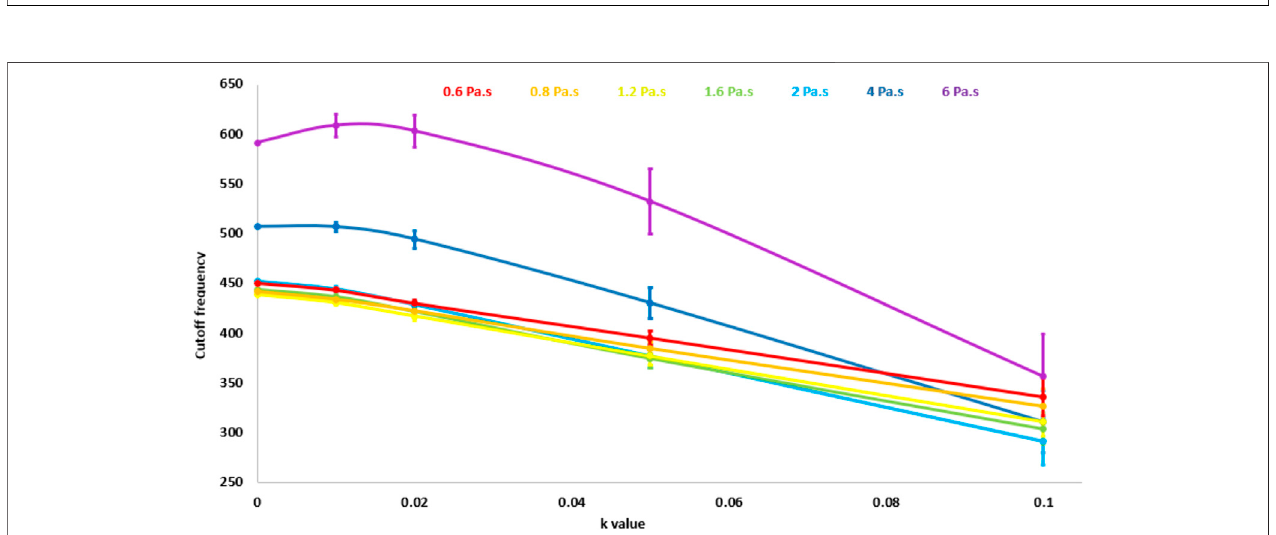
FIGURE5| Cutofffrequencyvaluesobtainedthroughtheautomaticmethodasafunctionofthenoiseparameter k .Eachcurvecorrespondstoadifferentviscosity degree.